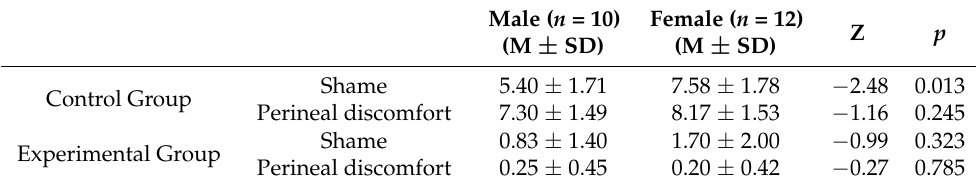
Table 2. Effects of wearing perineal underwear by